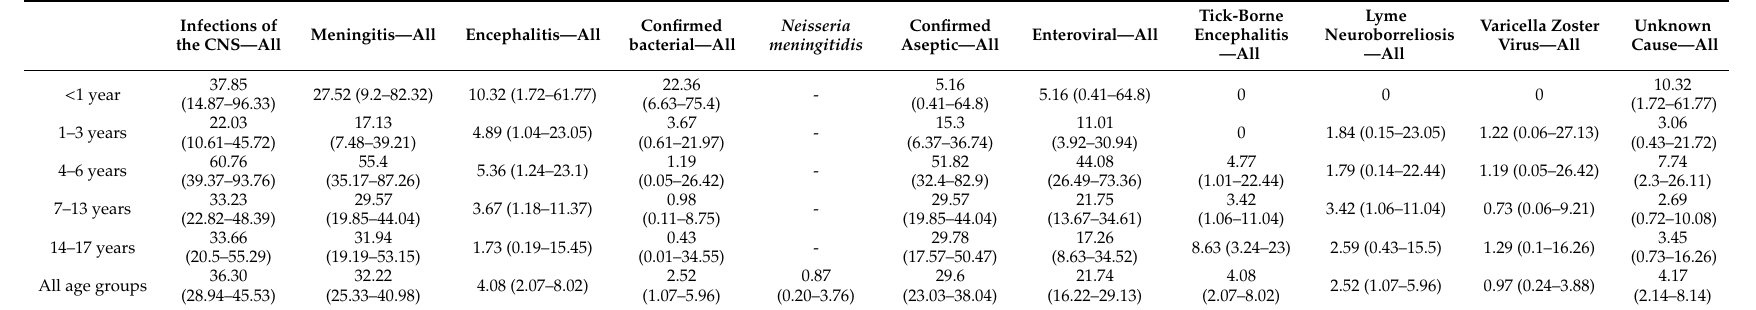
Table 3. Estimated annual incidence of meningitis and encephalitis per 100,000 population per year based on numbers recruited (95% CI).